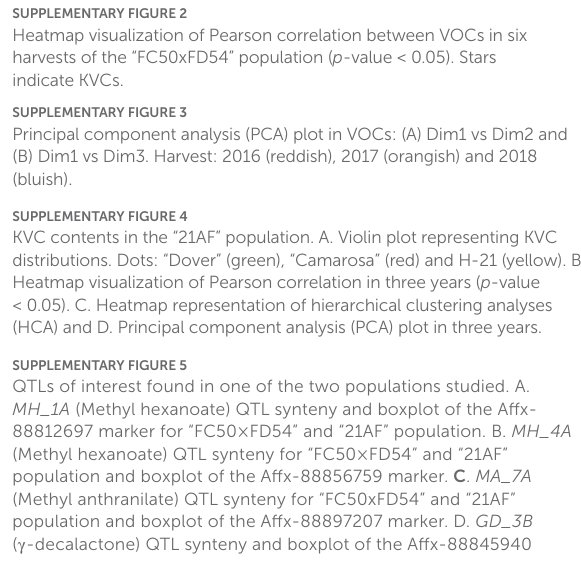
SUPPLEMENTARY FIGURE 1 Violin plot representing VOC distributions of parents and progeny of the “FC50 × FD54” population. Harvest colors: 2016 (reddish), 2017 (orangish) and 2018 (bluish). Dots: “FC50” (green), “FD54” (red). Stars indicate KVCs. SUPPLEMENTARY FIGURE 2 Heatmap visualization of Pearson correlation between VOCs in six harvests of the “FC50xFD54” population ( p -value < 0.05). Stars indicate KVCs. SUPPLEMENTARY FIGURE 3 Principal component analysis (PCA) plot in VOCs: (A) Dim1 vs Dim2 and (B) Dim1 vs Dim3. Harvest: 2016 (reddish), 2017 (orangish) and 2018 (bluish). SUPPLEMENTARY FIGURE 4 KVC contents in the “21AF” population. A. Violin plot representing KVC distributions. Dots: “Dover” (green), “Camarosa” (red) and H-21 (yellow). B. Heatmap visualization of Pearson correlation in three years ( p -value < 0.05). C. Heatmap representation of hierarchical clustering analyses (HCA) and D. Principal component analysis (PCA) plot in three years. SUPPLEMENTARY FIGURE 5 QTLs of interest found in one of the two populations studied.